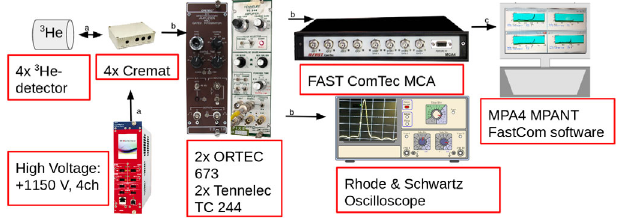
FIG. 8. DAQ system for the 3 He detectors. (a) HV cable, (b) BNC cable, (c) MCA-USB